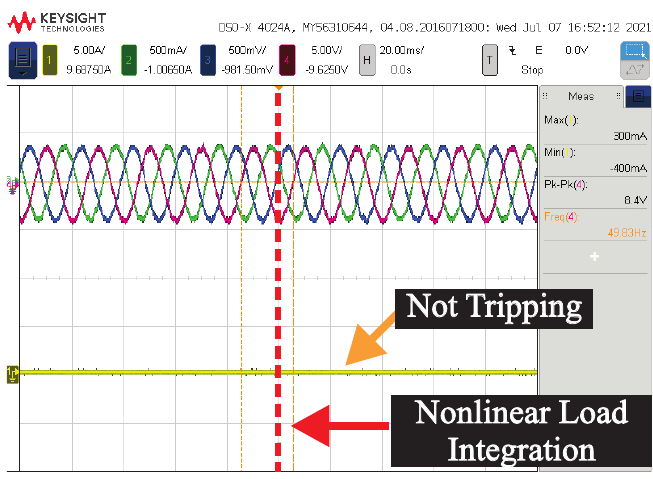
Figure 14. Nonlinear load integration tripping experimental results. The four islanding signals were triggered after 27 ms (DGU1), 32 ms (DGU2), 40 ms (DGU3), and 40 ms (DGU4). The acquired signals from the first three DGUs are shown